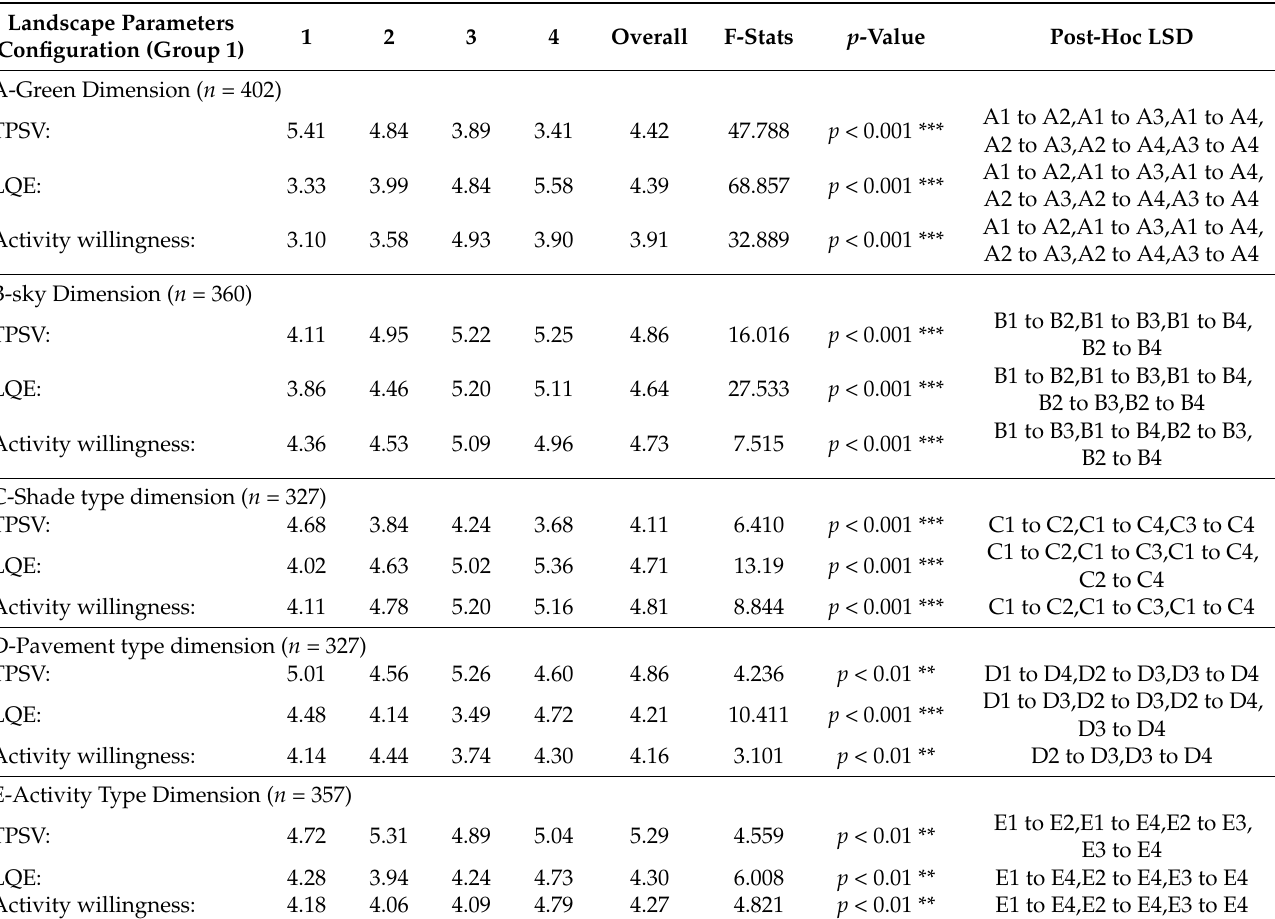
Table 7. TPSV means and ANOVA analysis and LSD post-hoc test for different landscape